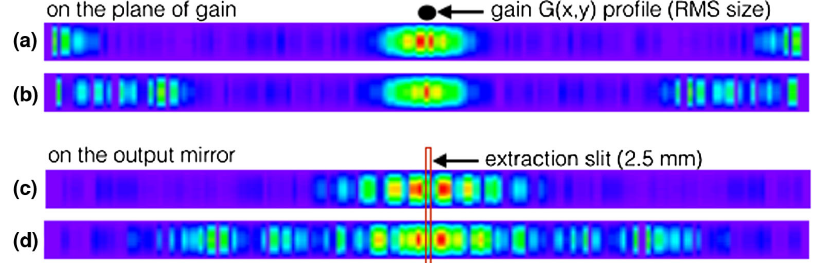
FIG. 6. Laser profile amplitude in the waveguide ( 200 × 1 cm), at various wavelengths: large power at 54 . 3 cm − 1 (a) (c), and zero power at 53 . 5 cm − 1 (b) (d); on the plane of gain (a) (b) and on the output mirror (c) (d).